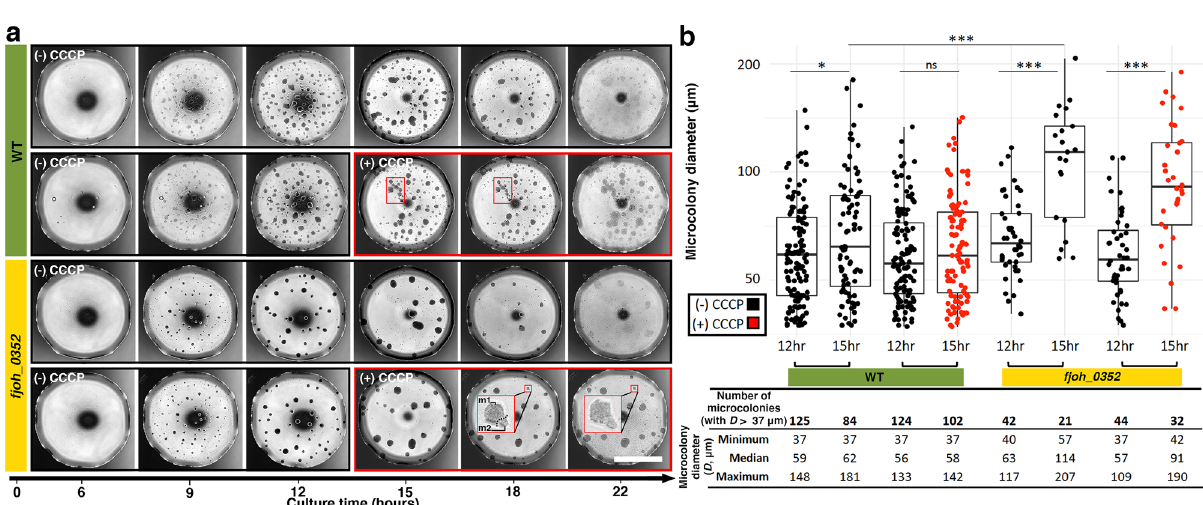
Fig. 3 Proton motive force (PMF) uncoupler shows microcolony motility and merging is an active process. a Comparison matrix with bright- fi eld microscopic images between wild-type (WT) and fjoh_0352 over time. A single biological replicate is shown in the matrix, representative of three biological replicates. Immediately after the 12 h time point, 10 μ M of carbonyl cyanide m-chlorophenylhydrazine (CCCP) was added to the microdrops, indicated by the large red box, with microdrops in the absence of CCCP as a control. CCCP inhibits PMF and causes microcolonies to freeze before merging, highlighted by the small red boxes. Scale bar, 1 mm. b Microcolony size (diameter, D ) and abundance as a function of time, F. johnsoniae strain, and presence ( + )/absence ( − ) of CCCP of the biological replicate shown in a . Only mature microcolonies ( D > 37 μ m) were quanti fi ed to measure merging and motility rather than formation of new microcolonies. Microdrops with ( + ) CCCP are displayed in red. Box edges and center represent the 25th, 75th, and 50th percentile while whiskers represent the minima and maxima. Signi fi cance was determined by a non-parametric, two-sided t -test: * P = 0.0469, ***P < 1.8e − 5, and ns non-signi fi cant. Source data are provided as a Source Data fi